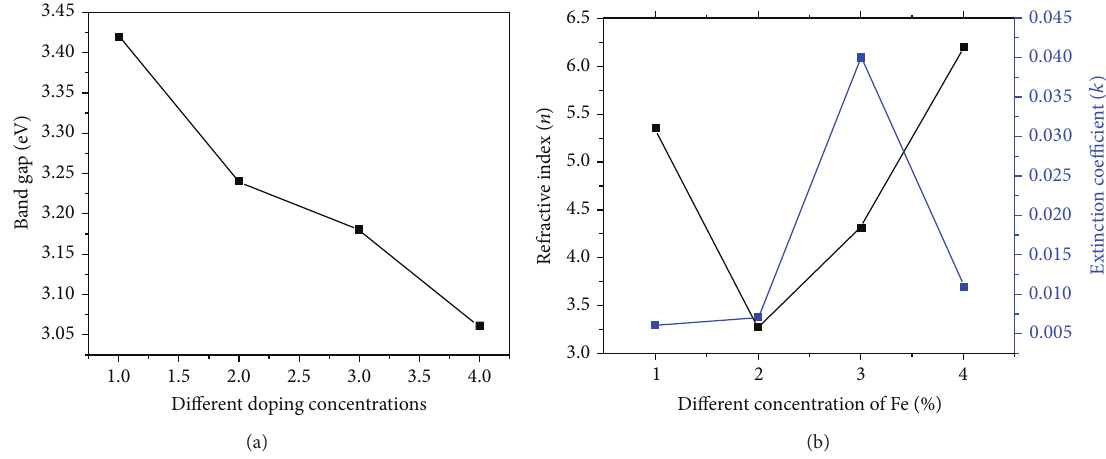
Figure 8: The figure shows (a) band gap versus different Fe % and (b) refractive index and extinction coefficient versus different Fe